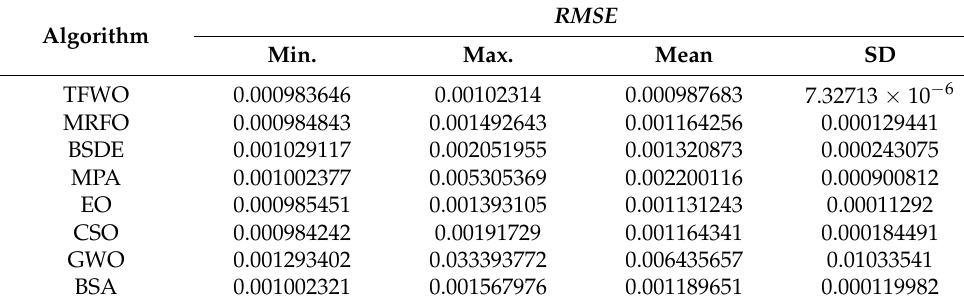
Figure 14. Characteristic curves for R.T.C. France TDM based on TFWO: ( a ) I–V ch/s and ( b ) P–V ch/s. For the 30 runs, the minimum, maximum, mean, and standard deviation of the RMSE are tabulated in Table 8. As shown, the proposed TFWO gives the lowest values of the minimum, maximum, mean, and standard deviation as 0.000983646, 0.00102314, 0.000987683, and 7.32713 × 10 − 6 , respectively. Figure 16 displays the RMSE values of the 30 runs for the R.T.C. France TDM, which demonstrate the efficacy of the proposed TFWO in finding the minimum RMSE values compared to the others. Table 8. Statistical analysis of RMSE for R.T.C. France